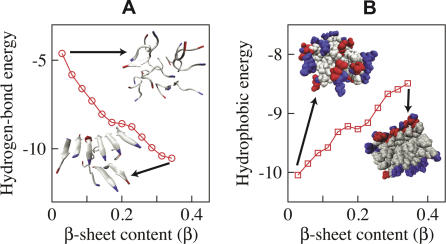
Coalescence and Reorganisation of Aβ16–22
Competition between hydrophobicity and hydrogen bonding in the formation of ordered oligomers formed by the Aβ16–22 peptide. (A) Average interchain hydrogen-bond energy per chain and (B) average interchain hydrophobic energy with respect to the order parameter β. Two representative oligomer configurations are shown corresponding to β = 0 and β = 0.36; comparison of these structures illustrates the process of internal reorganisation that leads to increases in both the number of hydrogen bonds and in the exposure of hydrophobic groups (gray spheres).